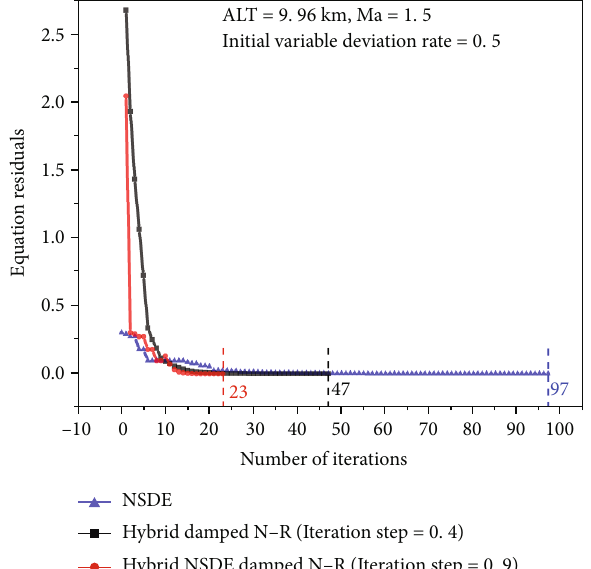
Figure 11: Variation of equation residuals with the number of component calculations for di ff erent iterative algorithms under Alt = 9 : 96km and Ma = 1 : 5 .